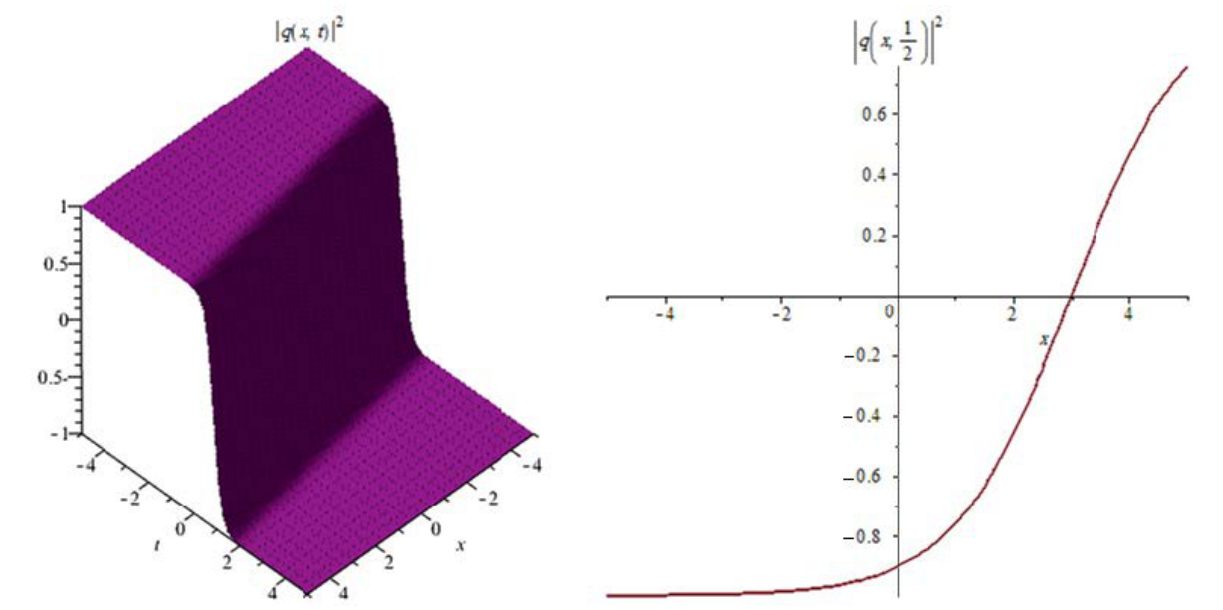
Figure 12. The profile of the combination of dark-bright soliton solutions (51). Figure 13: The numerical simulations of the solutions (55) 3D and 2D (with t = 1 with the parameter values a 1 = 1, a 2 = 1, b = 16, σ = 0, α = 2, κ = 2, w = 2, λ = 2, − − µ = 2, c = 10, v = 7, 5 5. x , t ≤ ≤